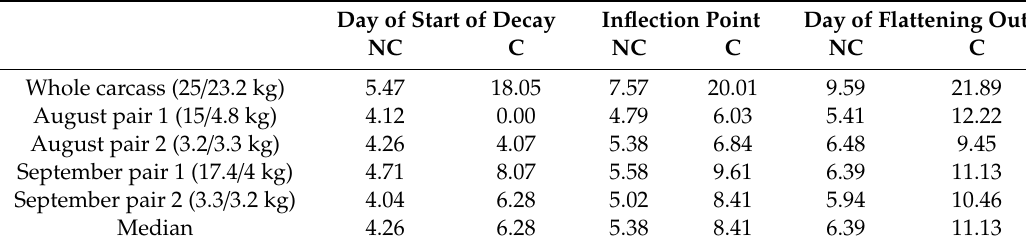
Table 2. Values obtained by fitting a four-parameter Weibull model by non-linear regression to the consecutive weigh of the roe deer carcasses deployed to simulate lynx kills (NC: not covered; C: covered). In parentheses, it is reported the initial weight of the not covered/covered carcasses/carcass parts. Day of start of decay = minimum value of the second order derivate, inflection point = minimum value of the first order derivate and day of flattening out of the decay curve = maximum value of the second order derivate.